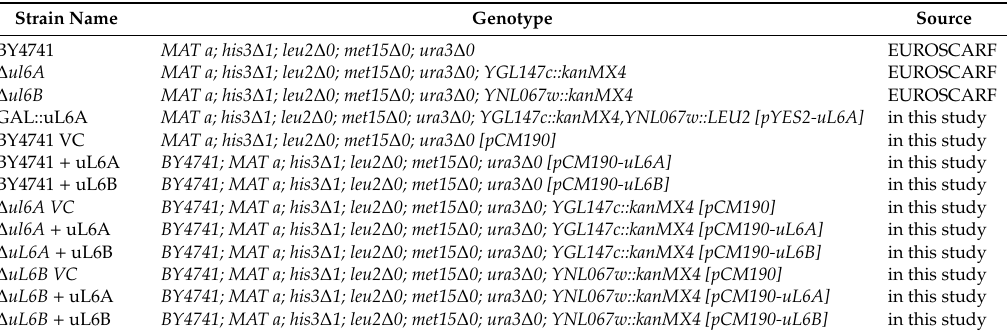
Table 1. Yeast strains used in this